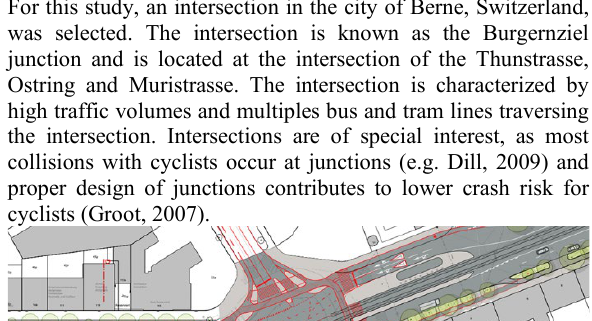
Figure 6. Trajectories (shown in blue) of the backpack image acquisition along the sidewalks on both sides of the streets.